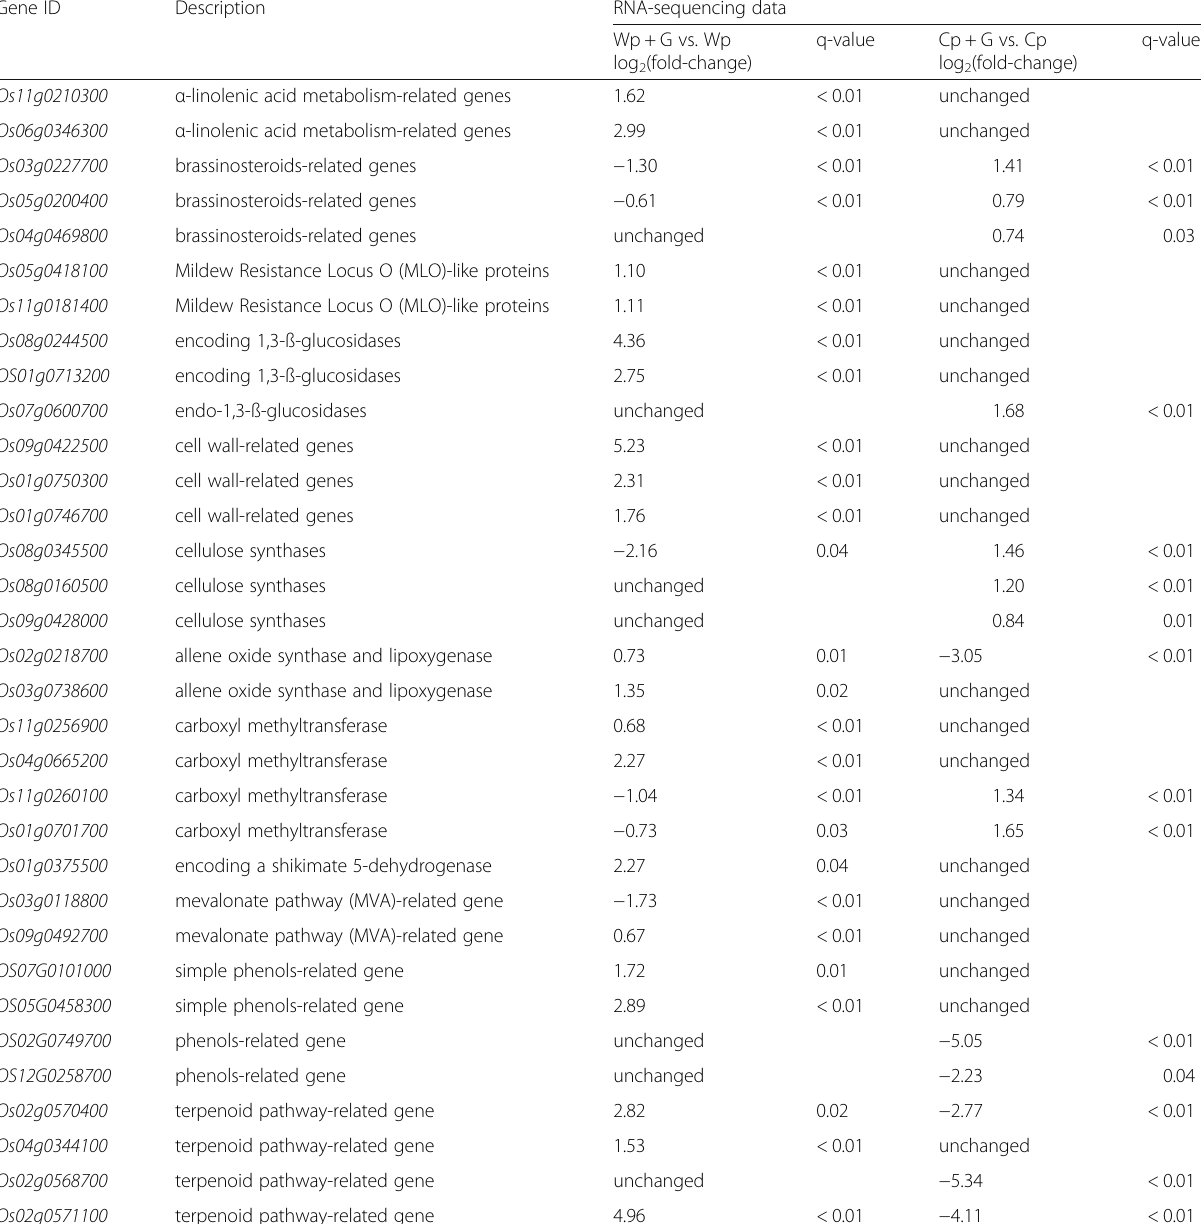
Table 5 List of several important differentially expressed genes derived from W + F versus W (Wp + R vs. Wp) comparison and Cp + R versus C (Cp + R vs. C) comparison. Cp + R, Rhizoglomus intraradices -inoculated cultivated rice infected with M. oryzae ; Cp, R. intraradices - uninoculated cultivated rice infected with M. oryzae ; Wp + G, R. intraradices -inoculated wild rice infected with M. oryzae ; Wp, R. intraradices -uninoculated wild rice infected with M.